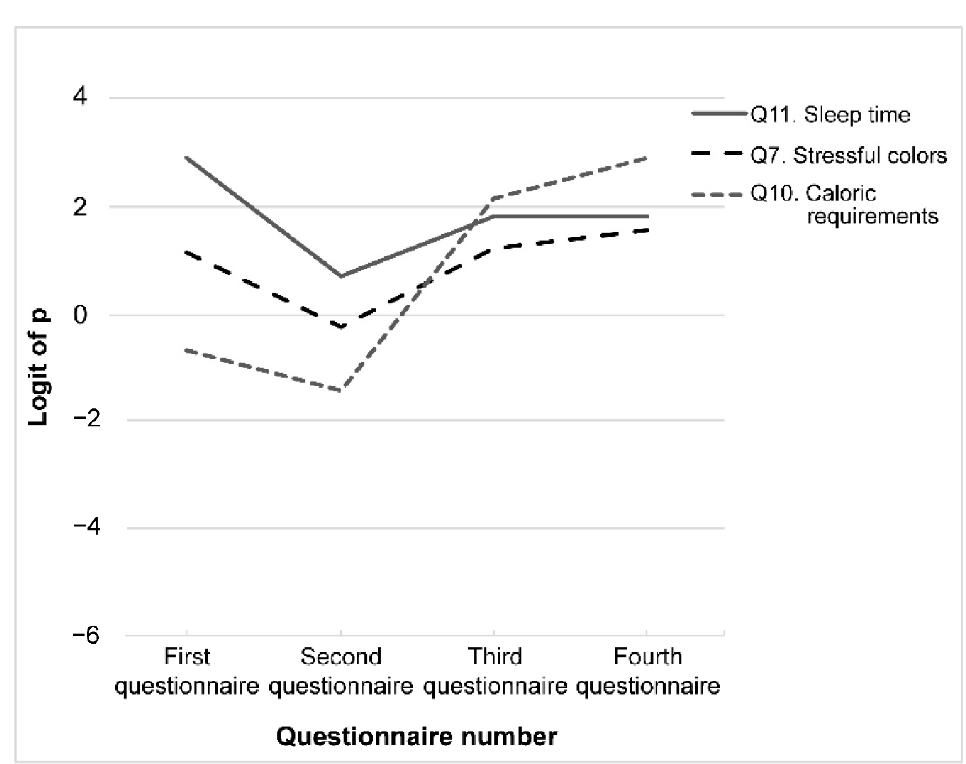
Figure 4. Pattern #2: Correct answer rate decreased after the first class. Questions with an estimated correct answer rate of “third > second < first” were selected. Each question is indicated using a different line.